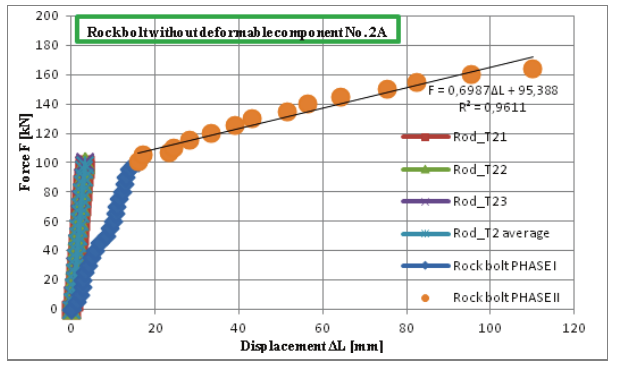
Fig. 28. Full loading characteristics for the rock bolt No. 2A